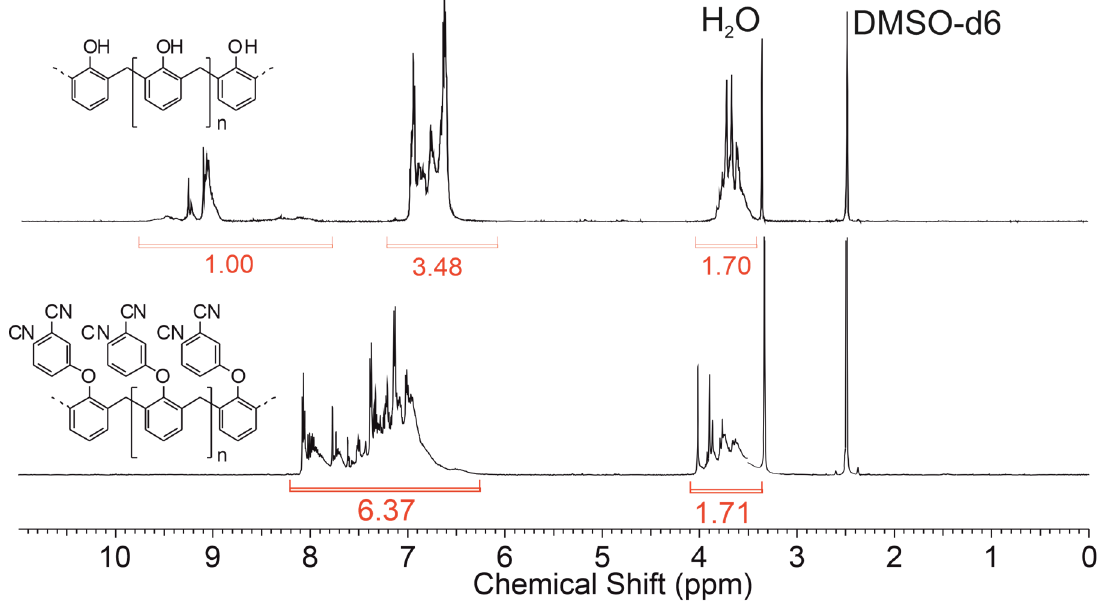
Figure 2. 1 H NMR spectrum of PNN synthesized in DMAc.